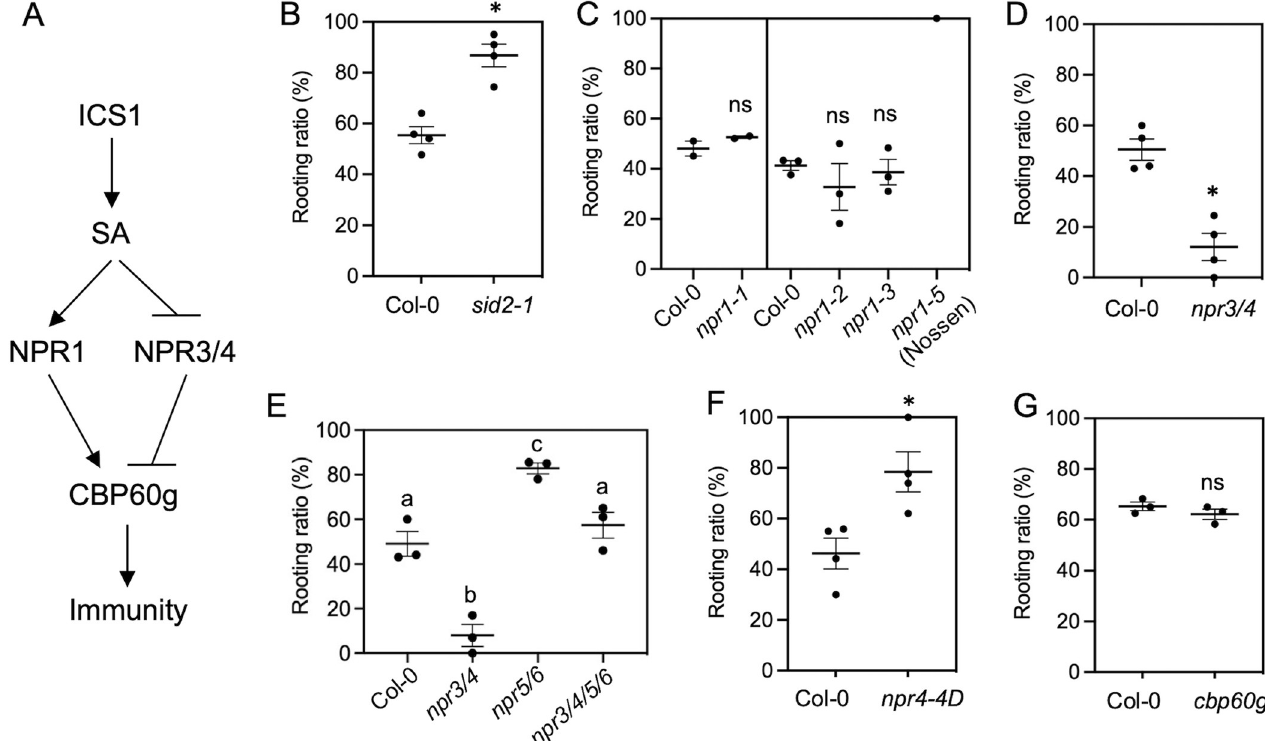
Fig 3. Genes involved in SA-mediated defense were differentially involved in DNRR. (A) A simplified pathway of SA signaling. (B)–(G) the rooting ratio in various SA mutants. Each dot represents an independent experiment with 40–60 explants. Error bars indicate standard error. The rooting data were collected at 11 DAC. � indicates p < 0.01 when comparing to Col-0 using student t-test. ns: not significant; Different letters in (E) indicate significant difference using one way ANOVA.